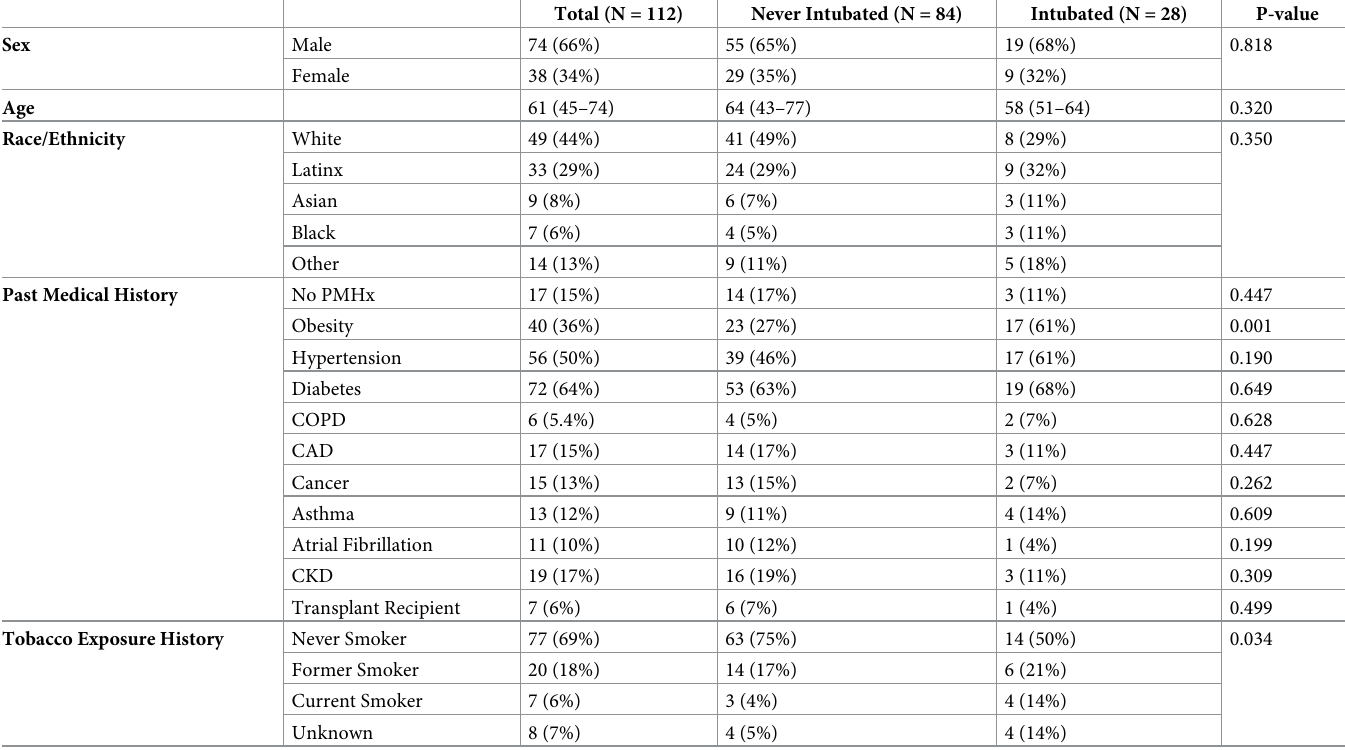
Table 1. Baseline characteristics of cohort.